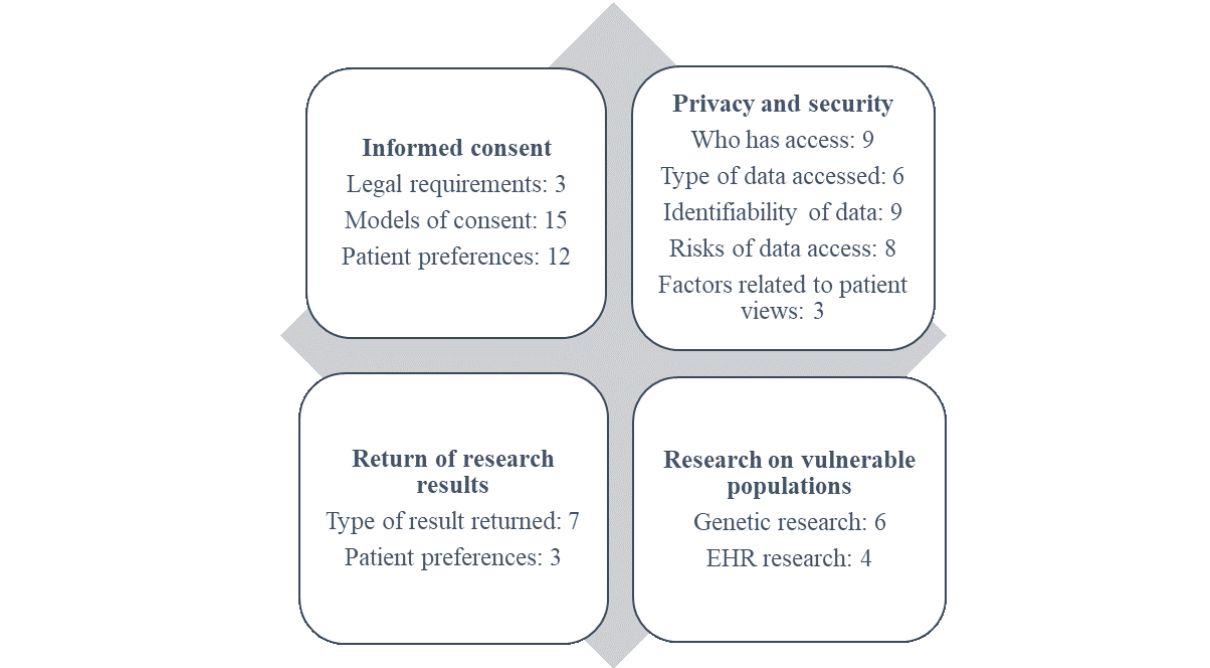
Figure 2. Number of articles included by ethical, legal, and social issue. EHR: electronic health